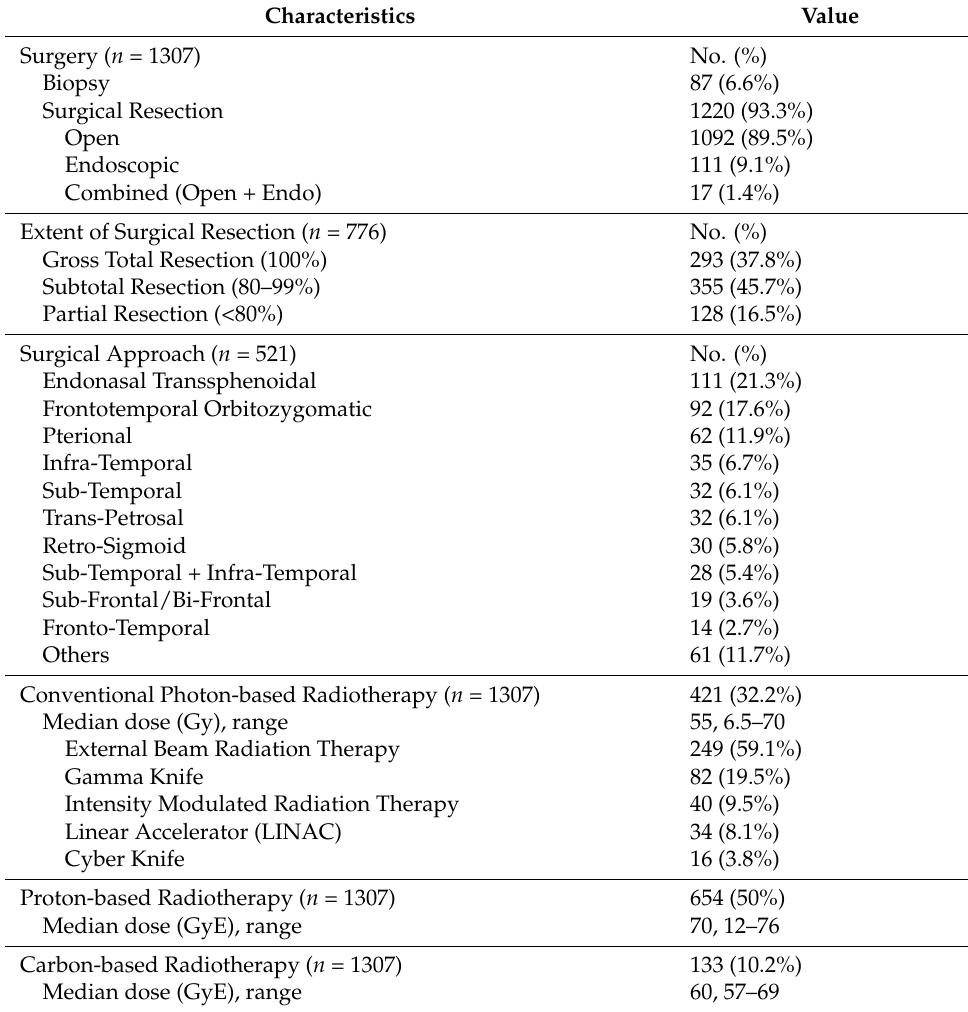
Table 3. Summary of management strategies of all pooled